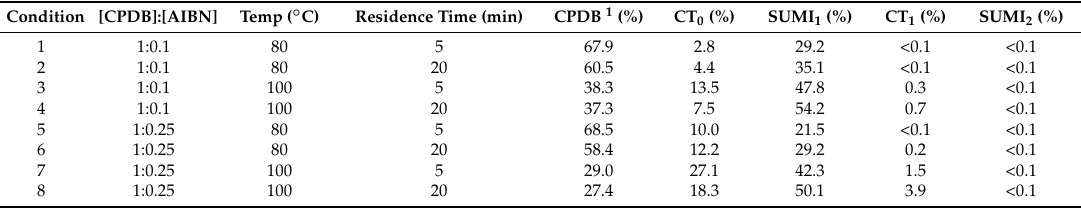
Table 1. Online screening results for CPDB RAFT polymerization reactions with 1 equivalent of the monomer n -butyl acrylate and 0.1 or 0.25 equivalents of the thermal initiator